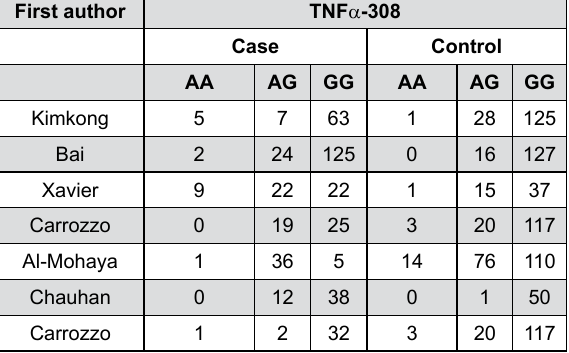
Figure 8- Distribution of TNF- α -308 genotype gene polymorphisms, underlying the need for future studies to investigate the HCV status of OLP